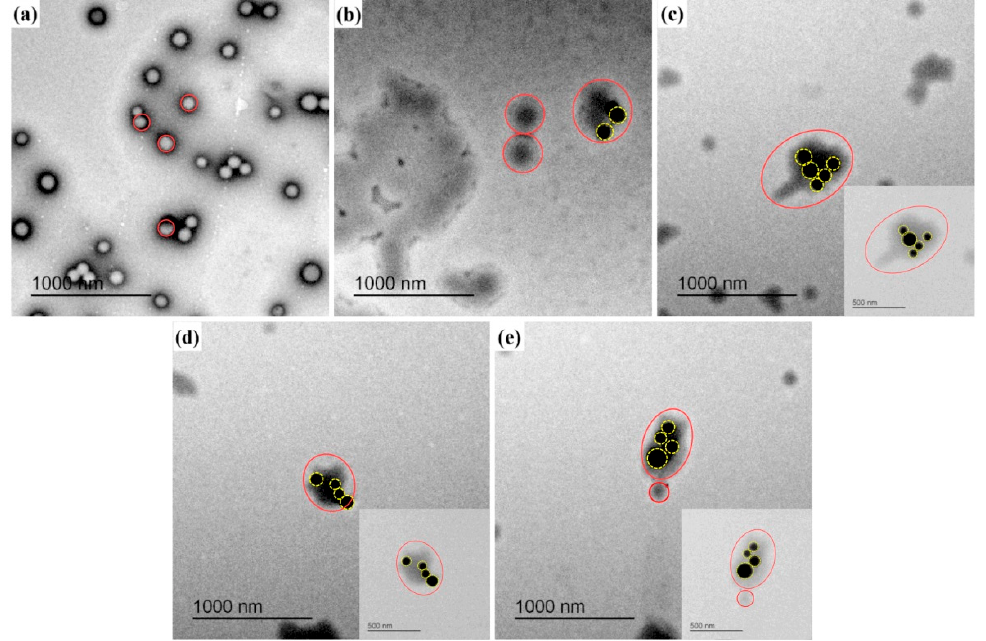
Figure 9. TEM images: ( a ) PMA latex, ( b ) PMA/SiO 2 composite, ( c ) PMA/KH550-SiO 2 composite, ( d ) PMA/KH560-SiO 2 composite, and ( e ) PMA/KH570-SiO 2 composite (Red circles refer to latex particles, yellow circles refer to SiO 2 particles).